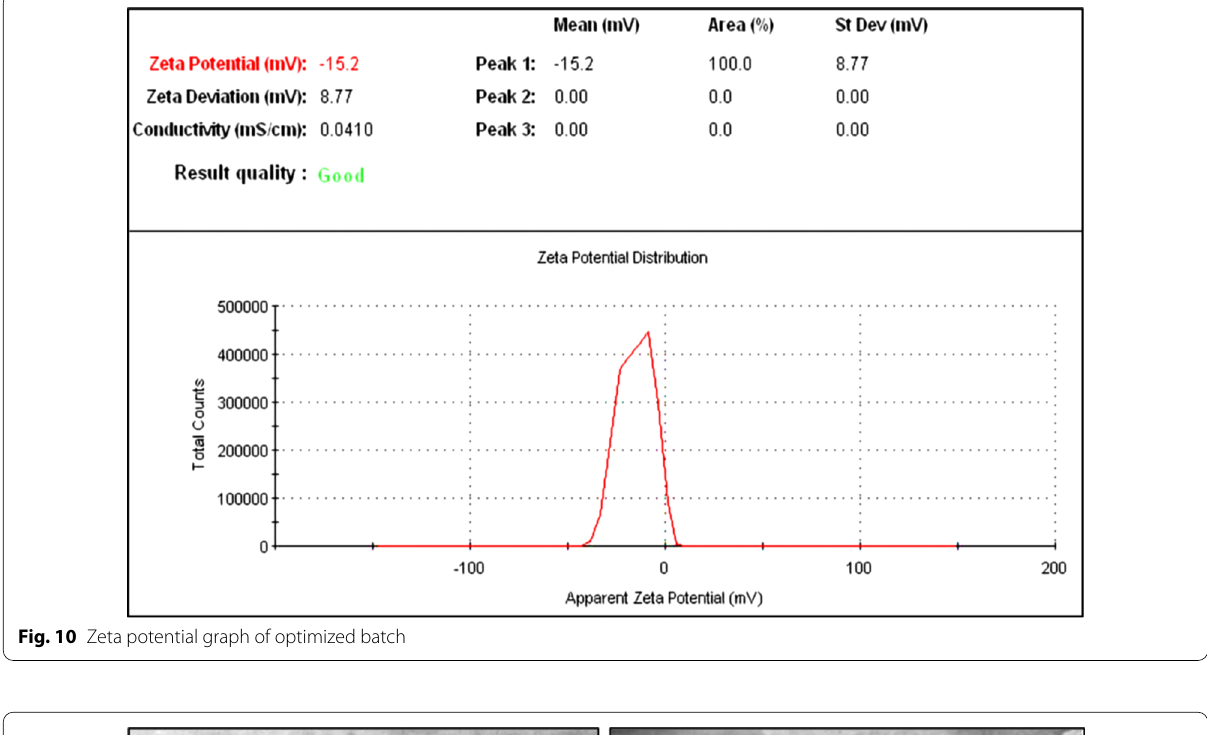
Fig. 10 Zeta potential graph of optimized batch